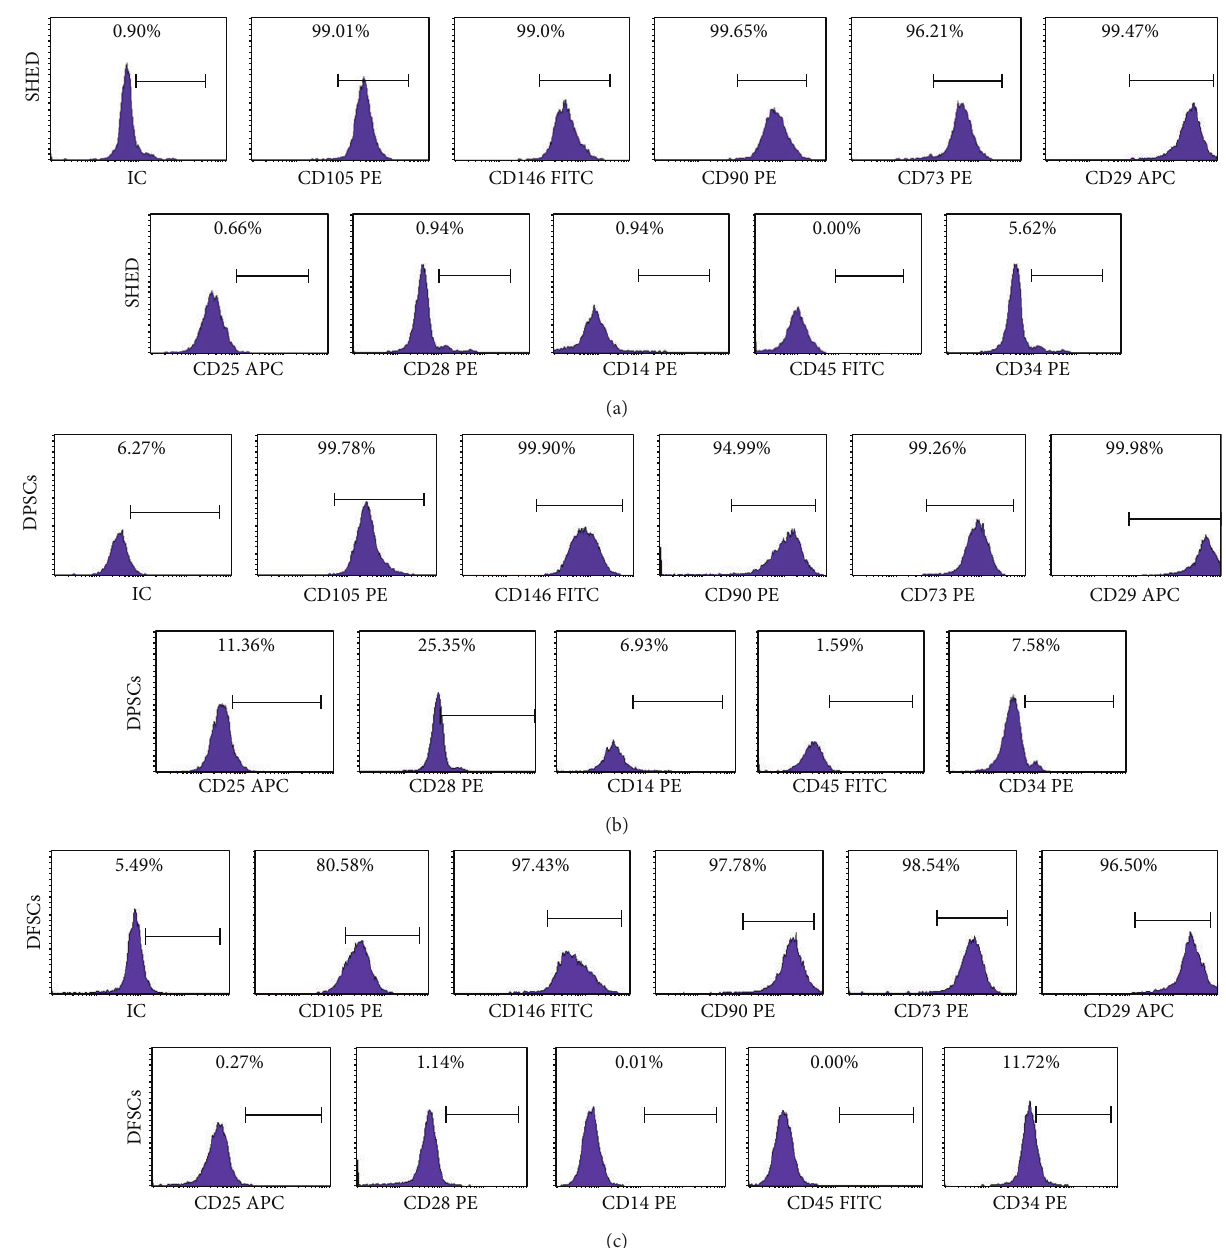
Figure2: RepresentativeflowcytometryanalysisofcellsurfacemarkersinSHED,DPSCs, andDFSCs.Representativeflowcytometryanalysis of cell surface markers (a) on SHED in P3, (b) on DPSCs in P3, and (c) on DFSCs in